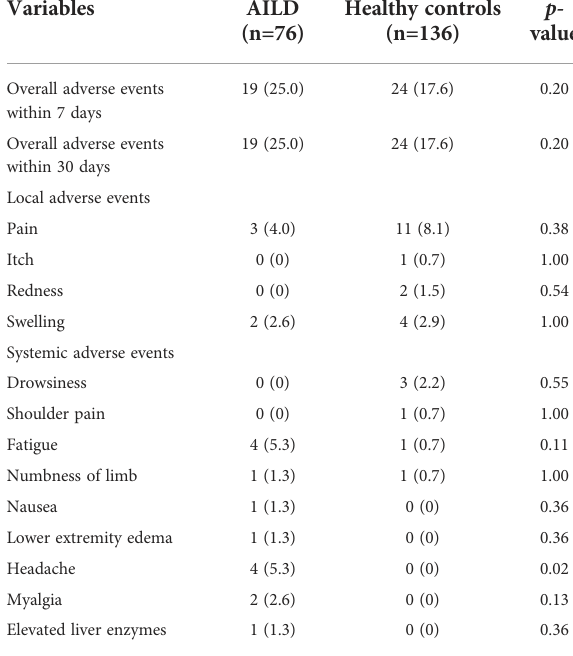
1:320 before vaccination. It increased to 1:1000 after vaccination, but the liver function test, serum IgG, anti-liver-kidney microsomal, anti-smooth muscle, anti-mitochondrial antibodies, and anti-soluble liver antigen were normal, and the patient had no symptoms of discomfort.